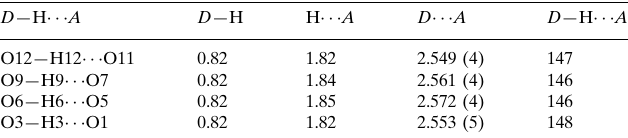
Hydrogen-bond geometry (A˚ , (cid:1)